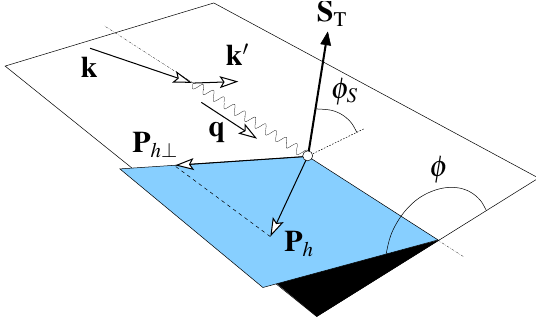
Figure 1 . Following the Trento conventions [7], φ is defined to be the angle between the lepton scattering plane and the plane spanned by the virtual-photon momentum q ≡ k 0 − k (the difference of the momenta of the outgoing and incoming lepton) and P h , the momentum vector of the observed hadron, about the virtual-photon axis. Likewise, the angle φ S is defined as the angle between the lepton scattering plane and the target-polarization vector S T of the transversely polarized nucleon. (cid:0) x, p 2 (cid:1) and the Boer-Mulders distribution Two TMD PDFs, the Sivers distribution f ⊥ ,q T 1 T h ⊥ ,q